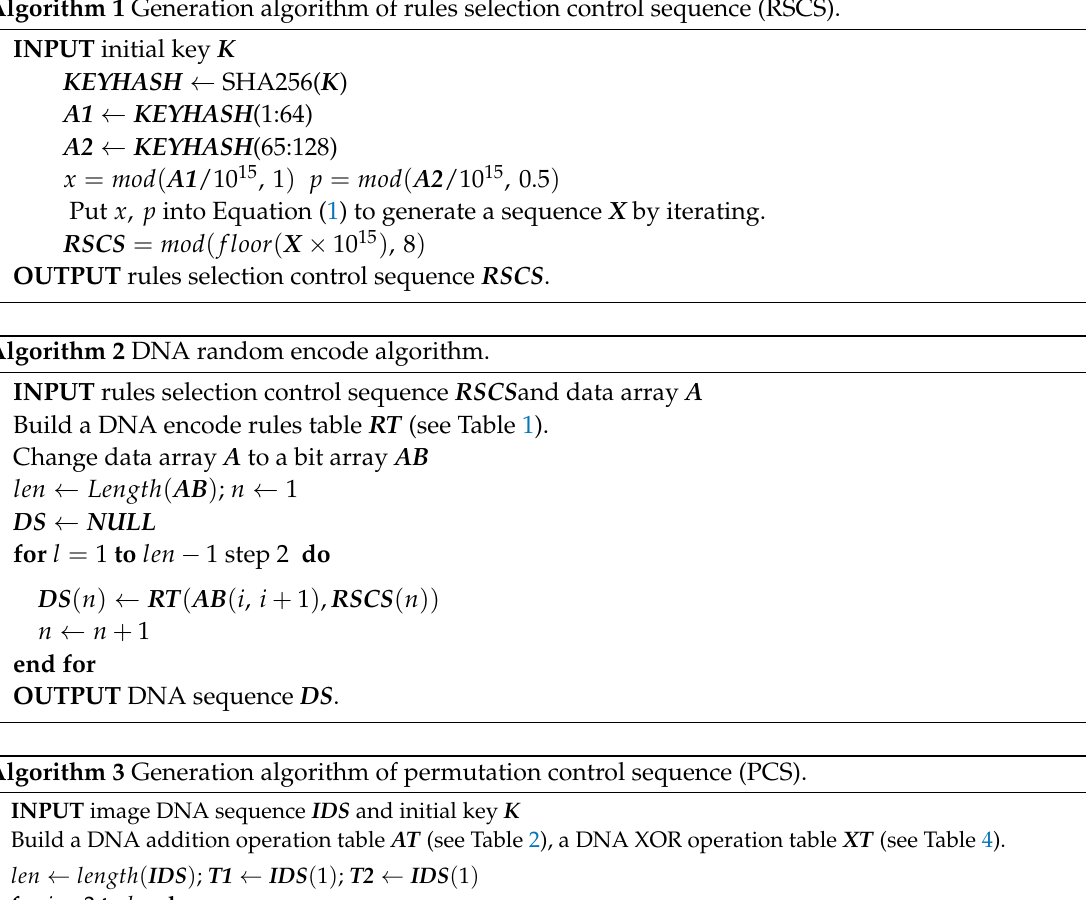
Step 8: Input permutated image sequence PIS and key DNA sequence KDS into Algorithm 6 to do DNA diffusion operation, and generate a diffused sequence DS . Step 9: Put diffused sequence DS and rules selection control sequence RSCS into Algorithm 7 to decode DNA sequence to a recovered image array RIA .